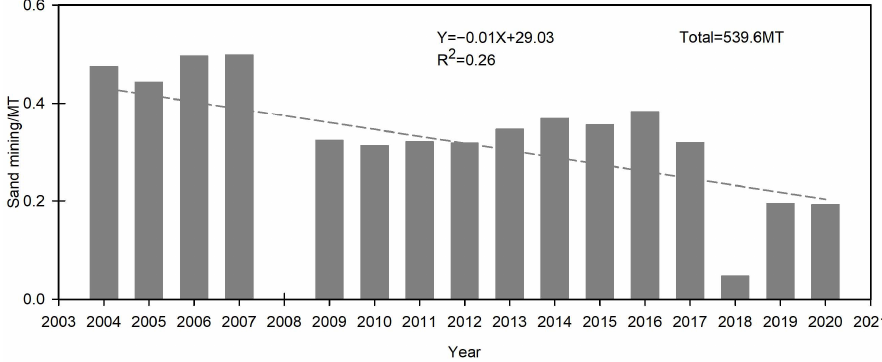
Figure 5. Annual sand mining quantity from Poyang Lake during 2004 – 2020.